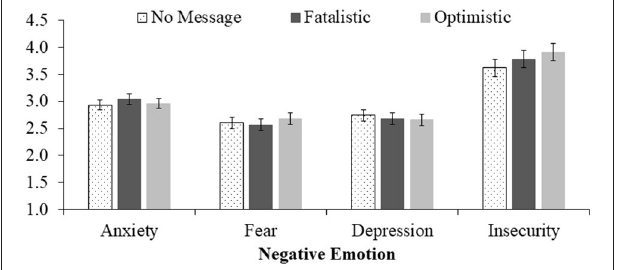
FIGURE 3 | Path Model of Indirect and Direct Effects of Messaging Condition on Support for Mitigation Efforts Through the Mediator of Fatalism toward COVID-19.